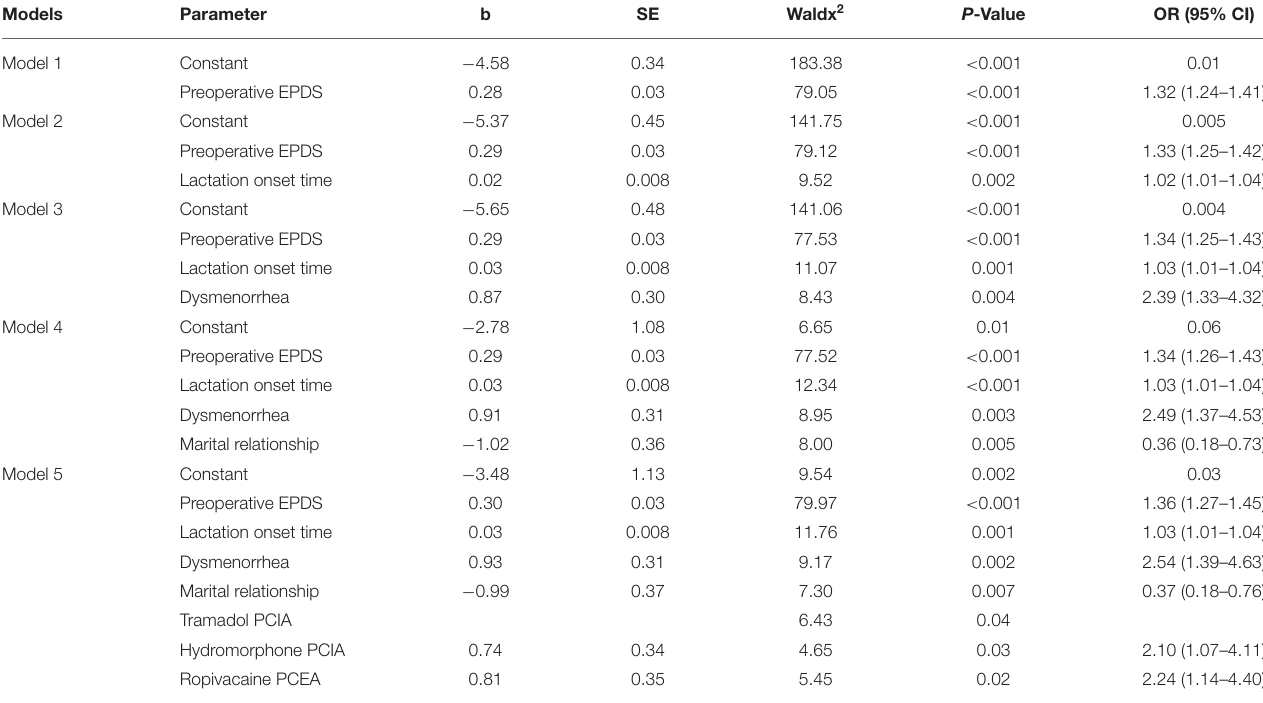
TABLE 4 | Stepwise binary logistic-regression models for selecting potential risk factors for PPD in 4 weeks after cesarean. Models